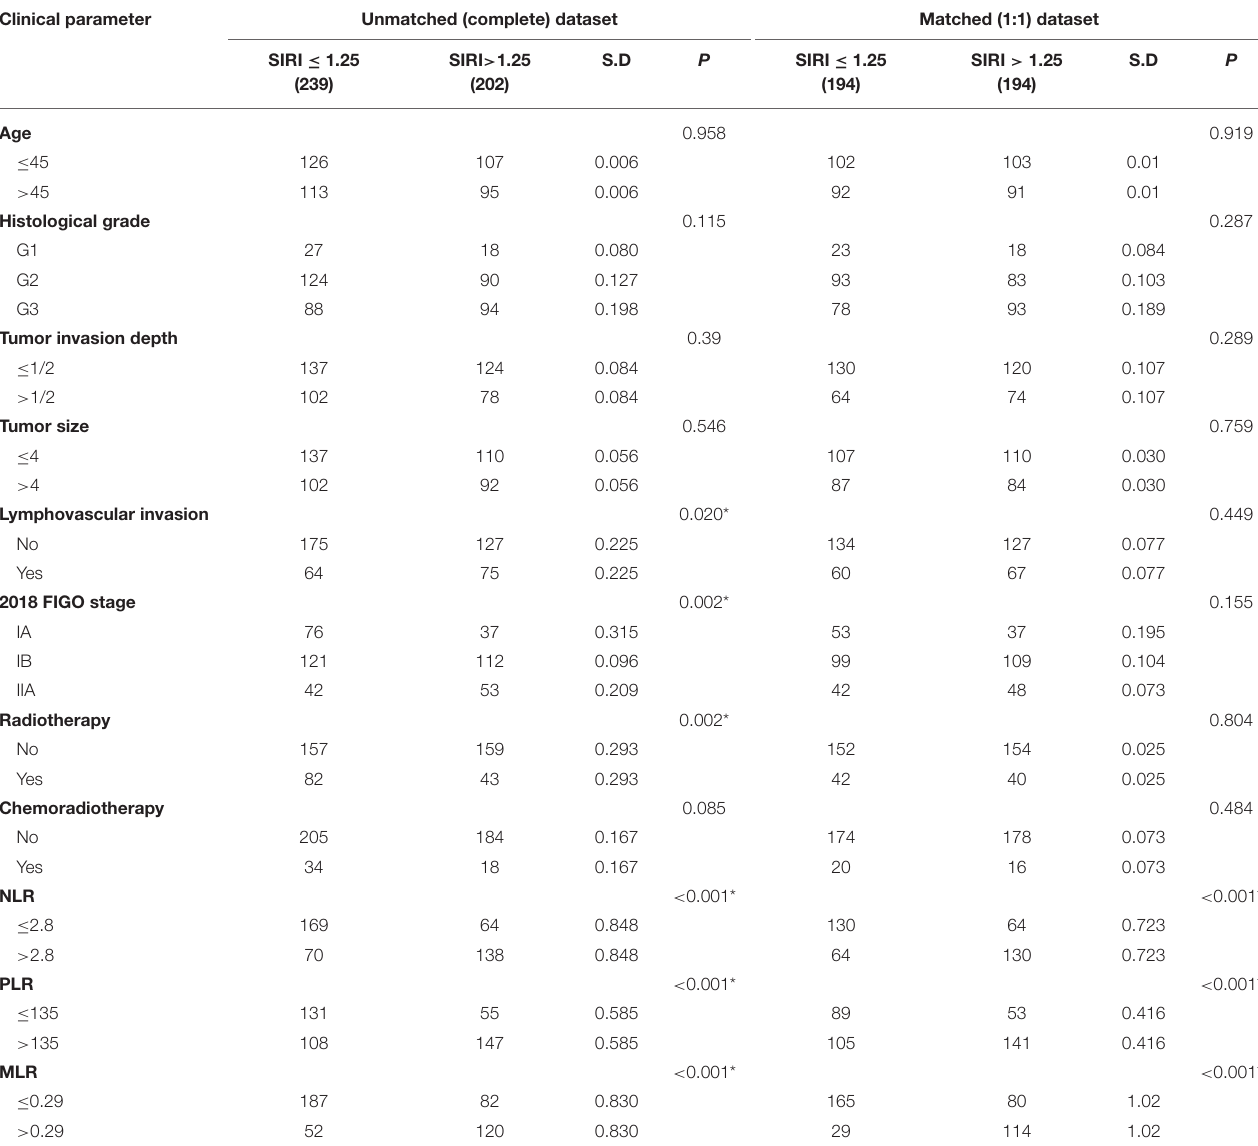
FIGO, International Federation of Gynecology and Obstetrics; SIRI, Systemic Inflammation Response Index; NLR, neutrophil lymphocyte ratio; PLR, platelet lymphocyte ratio; MLR: monocyte lymphocyte ratio; S.D, standardized difference. * Statistically significant (P < 0.05).